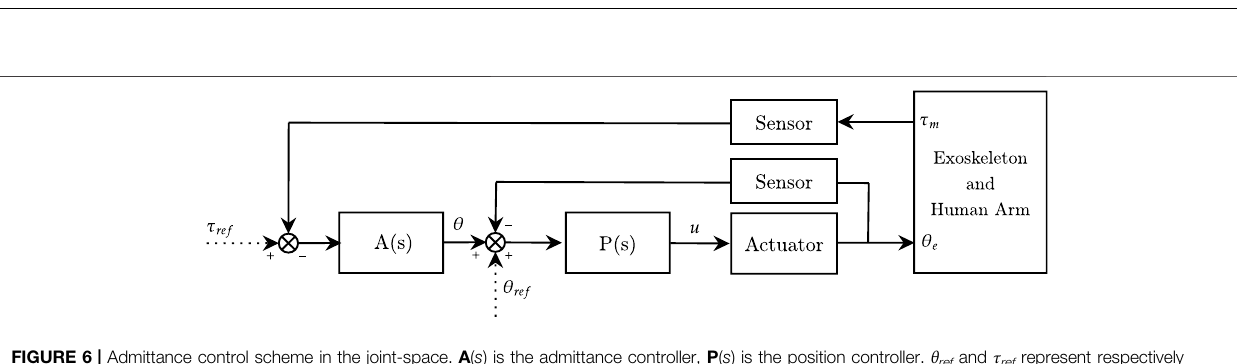
FIGURE 5 | Impedance control scheme in the Cartesian-space. Implicit (black) and explicit (black and gray). I ( s ) is the impedance controller, F ( s ) is the force controller (only explicit). FK represents the forward kinematics model of the exoskeleton, and J T corresponds to the transposed Jacobian matrix. θ ref and τ ref represent respectively reference angular position and torque, while u refers to the motor current control signal.